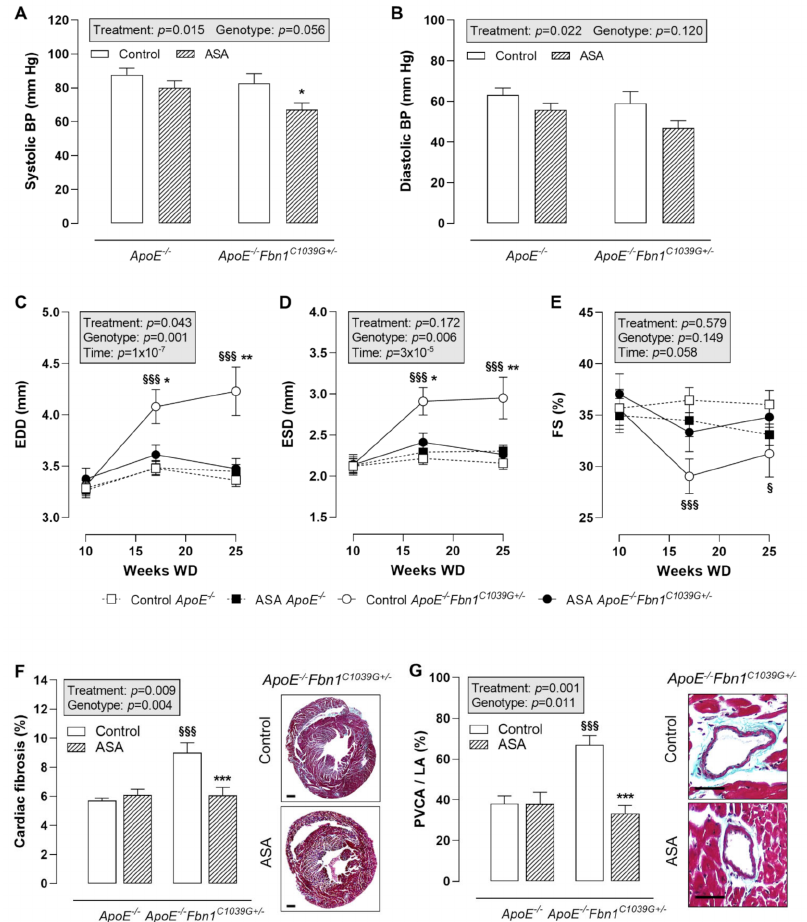
Figure 4. Blood pressure and cardiac remodelling. ( A , B ) Systolic blood pressure (BP) was lower